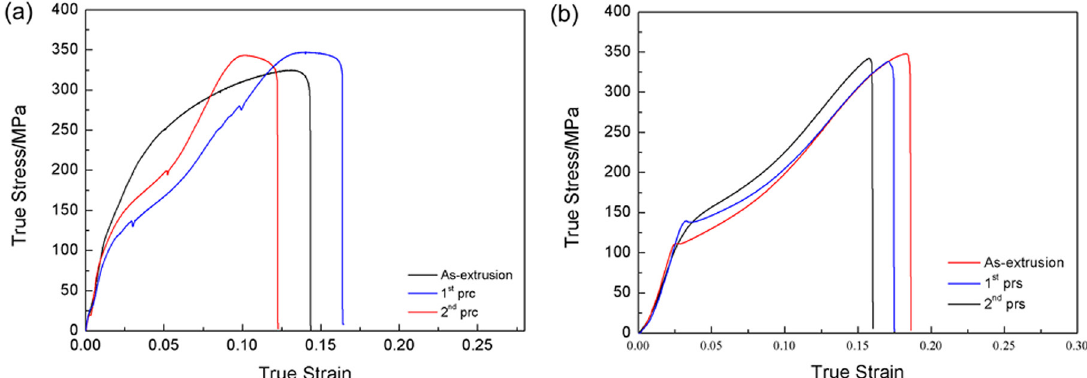
Figure 3. True strain vs stress curves of various pre-strain specimens: (a) tension, (b) compression